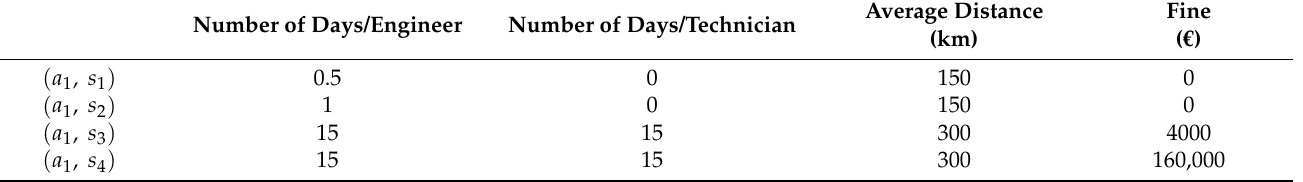
Table 3. Elements constituting the payoffs of each action.